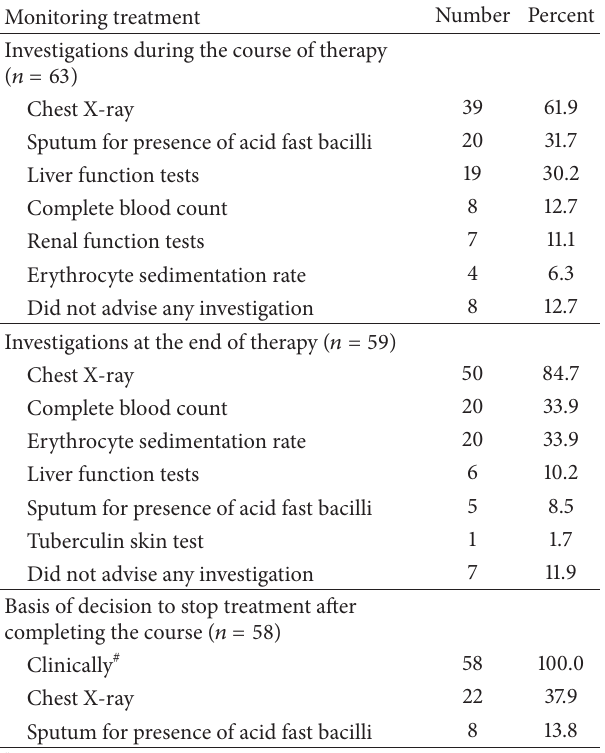
Table 5: Monitoring practices of paediatricians related to antituber- cular treatment among children in